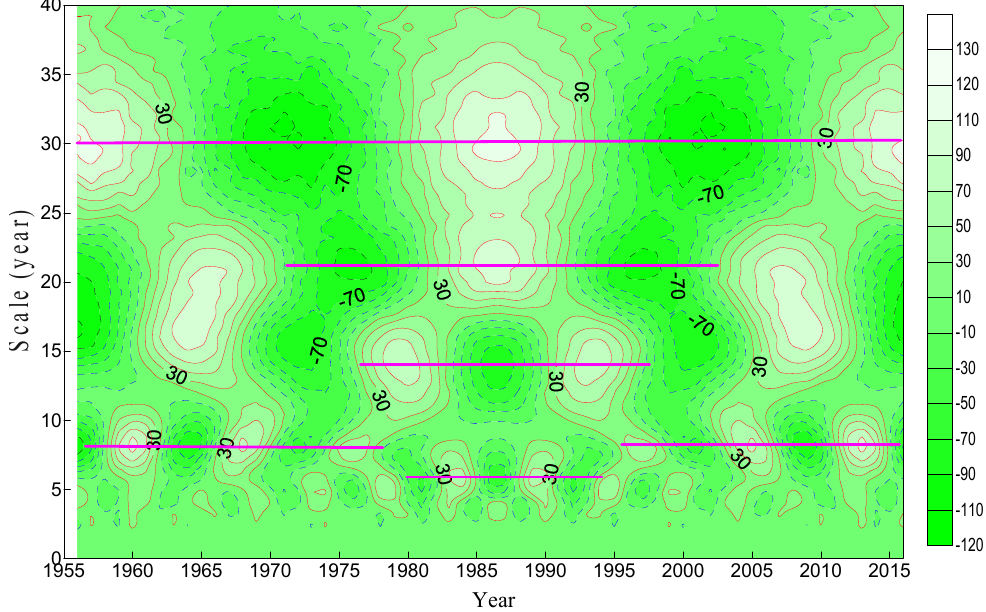
Figure 7. Real part coefficients contour map of streamflow at Lijin station.